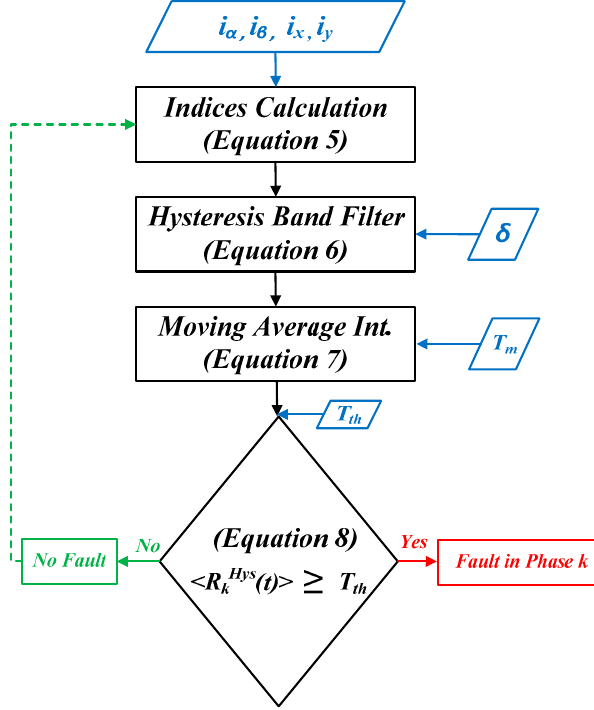
Figure 2. Flowchart of the indices-based fault detection technique.